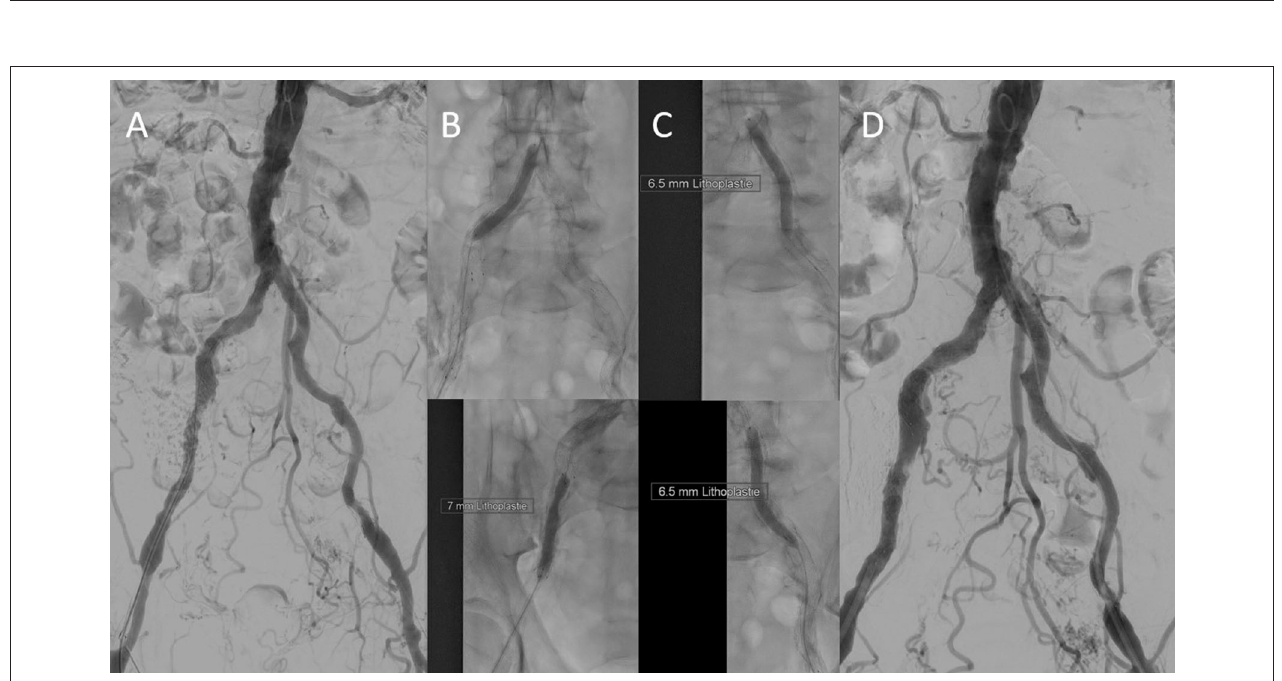
FIGURE 7 | Initial digital subtraction angiography confirmed severe calcification. (A) The right iliac arteries were dilated using a 7.0mm × 60mm intravascular lithoplasty (IVL) device (Shockwave Medical, Inc., CA, USA) (B) , after three cycles (90 pulses), the device ruptured. This was due to a malapposition of a distal stent strut in the external iliac artery. The left iliac axis was treated with five cycles (150 pulses) using a 7.0mm × 60mm IVL balloon (Shockwave Medial, Inc.) (C) . The result was satisfying (D) . Transfemoral TAVI (26mm Edwards Sapien 3, Edwards) was done 6 days later by using a 14F sheath via left femoral access. Nevertheless, after successful TAVI, the need for covered stent prosthesis implantation to fix external iliac artery perforation was necessary due to the heavy calcification.